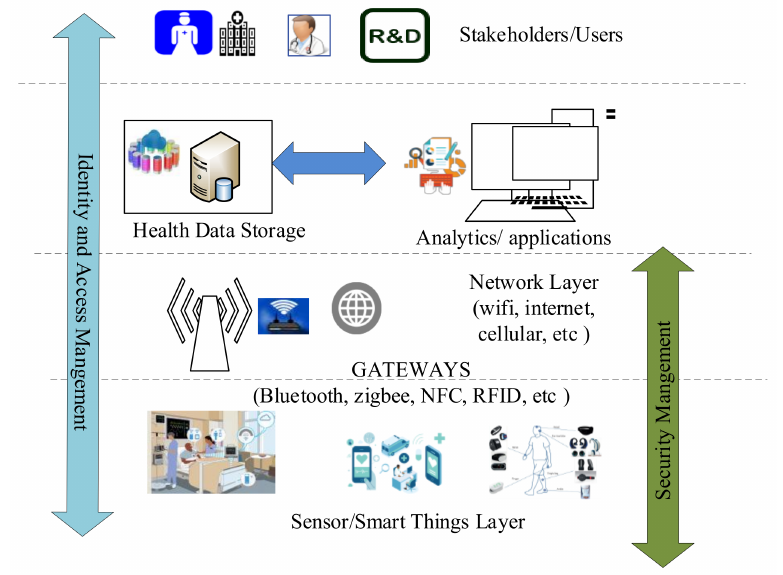
Figure 1. IoT enabled healthcare